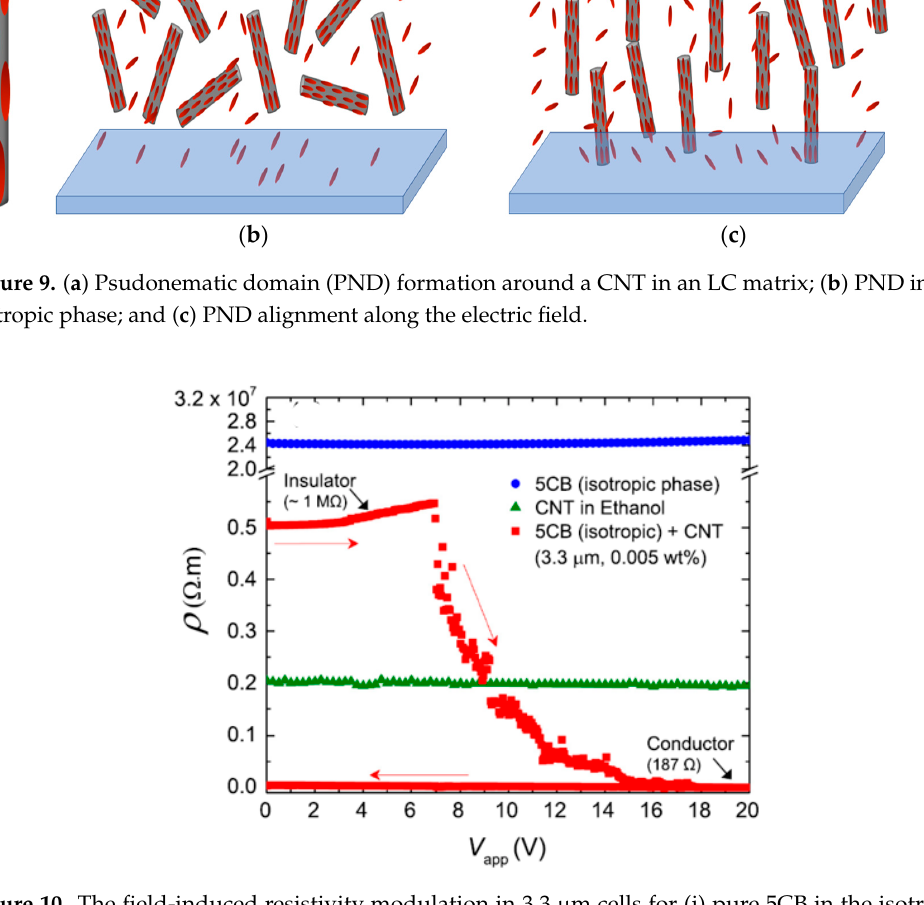
Figure 9. ( a ) Psudonematic domain (PND) formation around a CNT in an LC matrix; ( b ) PND in the isotropic phase; and ( c ) PND alignment along the electric field.